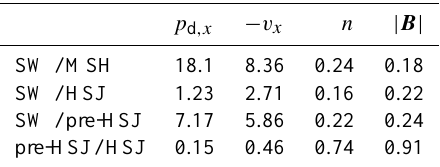
Table 1. Median values of ratio distributions shown in Fig. 5 (pan- els c, f, i, and